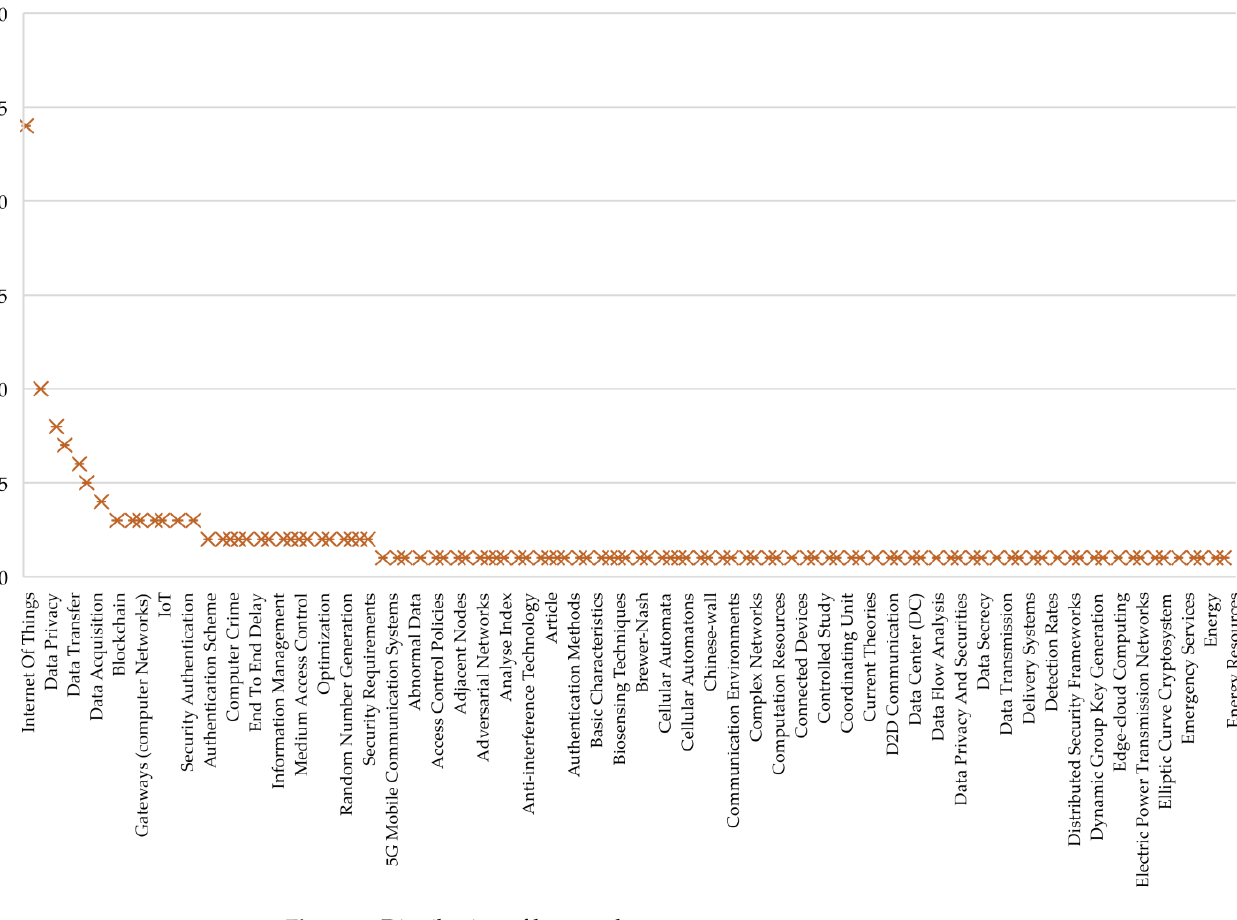
Figure 6. Distribution of keywords.